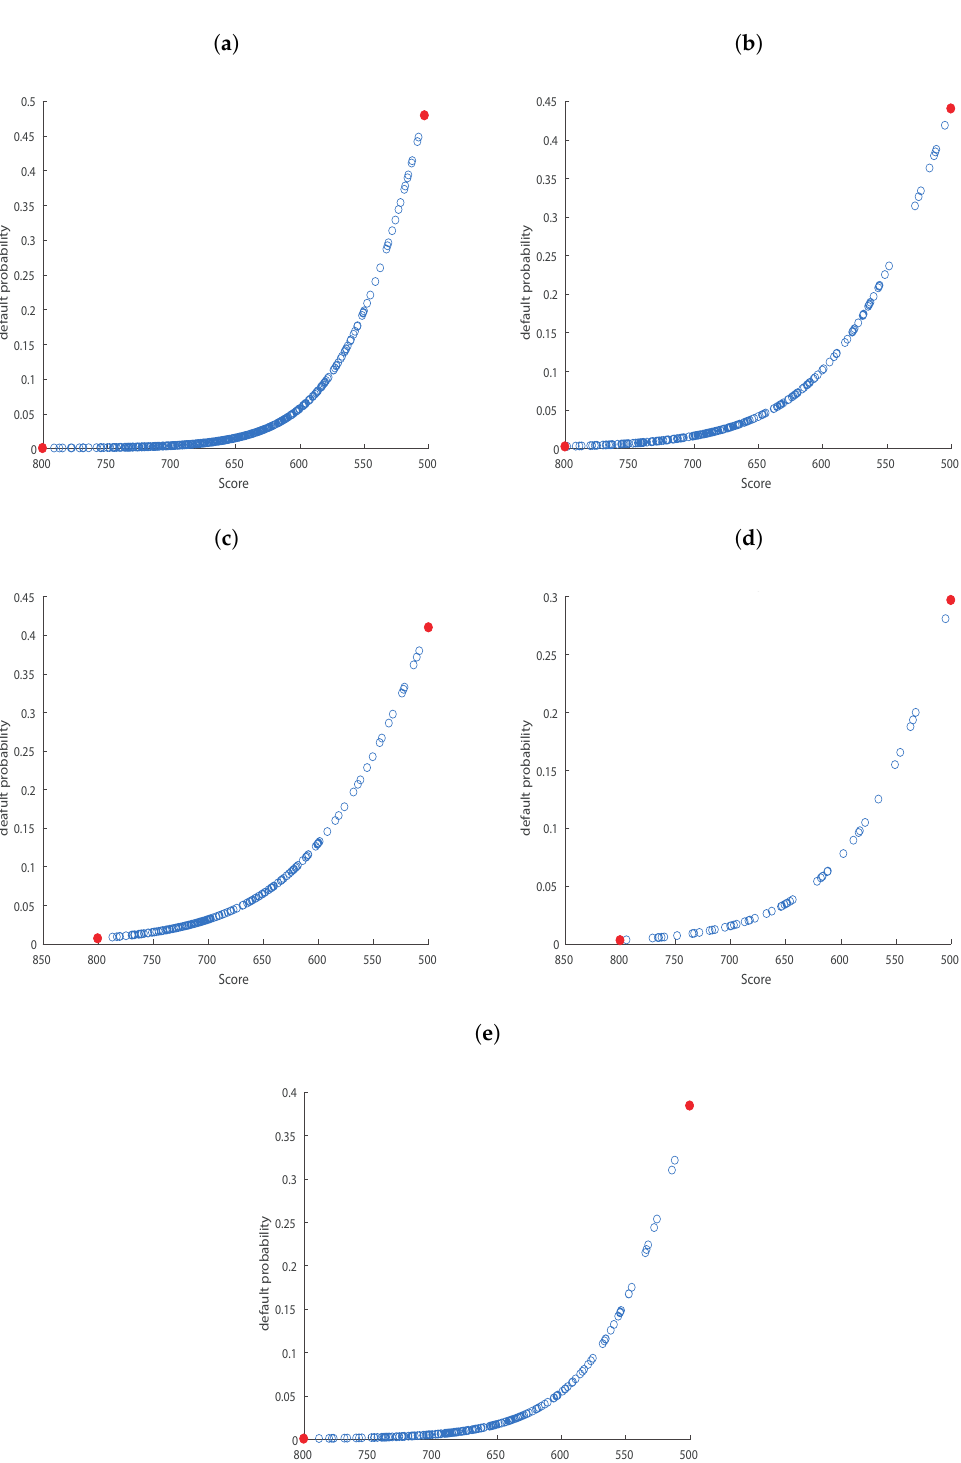
Figure A1. The figure illustrates the relationship between Score ( x -axis) and default probability ( y -axis) for 2014H1 (Panel ( a )), 2014H2 (Panel ( b )), 2015H1 (Panel ( c )), 2015H2 (Panel ( d )), 2016H1 (Panel ( e